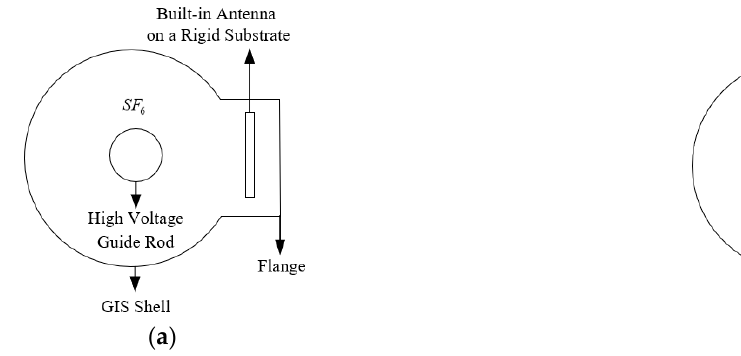
Figure 12. Antenna built-in GIS simplified model diagram: ( a ) Rigid Substrate Built-in Antenna Model; ( b ) Flexible Substrate Built-in Antenna Model.